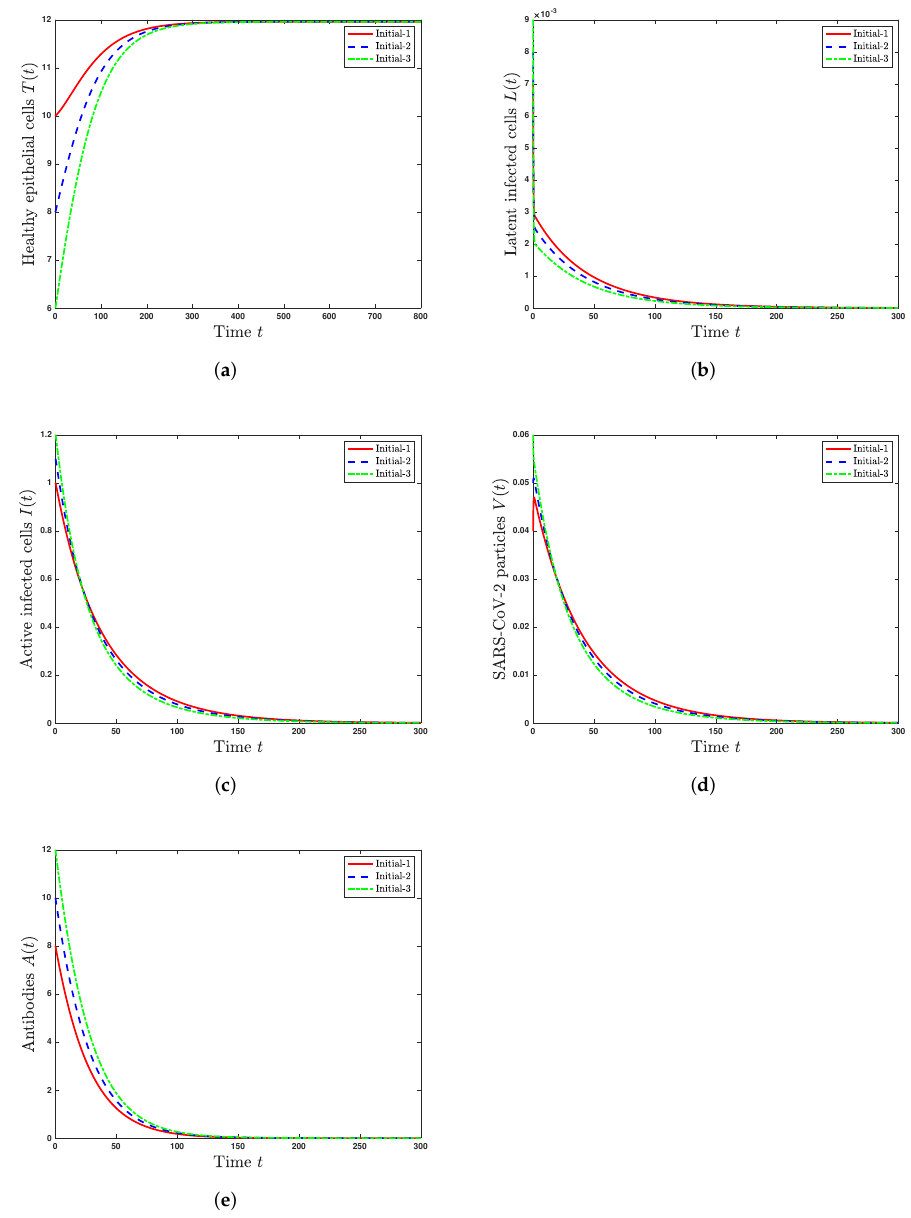
Figure 1. Solutions of system (19)–(23) with three initial conditions when R 0 ≤ 1. ( a ) Healthy epithe- lial cells; ( b ) latent infected cells; ( c ) active infected cells; ( d ) SARS-CoV-2 particles; ( e )